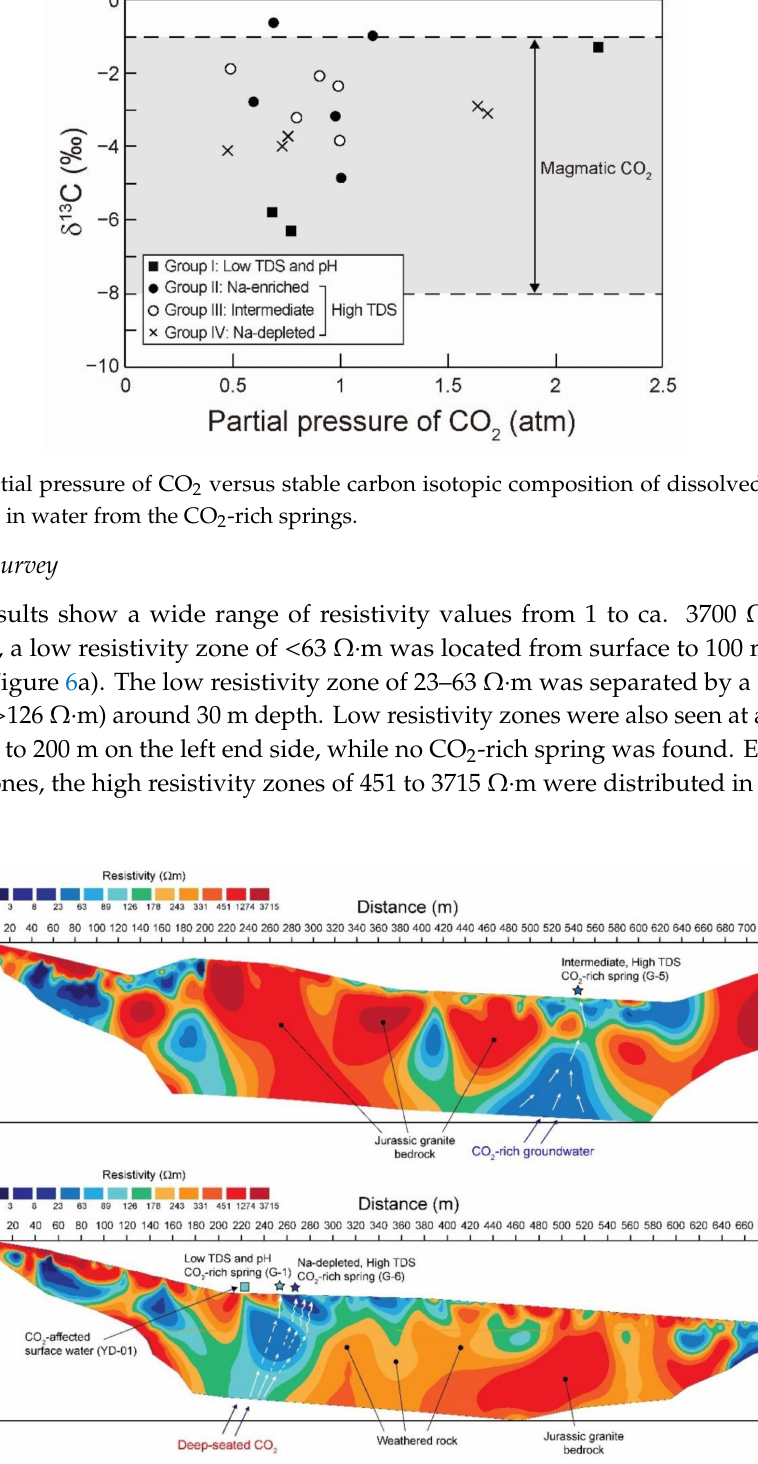
Figure 6. The results of electrical resistivity tomography along the survey lines: ( a ) ERT-1 and ( b ) ERT-2 (see Figure 1 for location). In ( b ), G-1 and G-6 are separate by approximately 7 m; the water running above ground at YD-01 is the seepage water a ff ected by the deep-seated CO 2